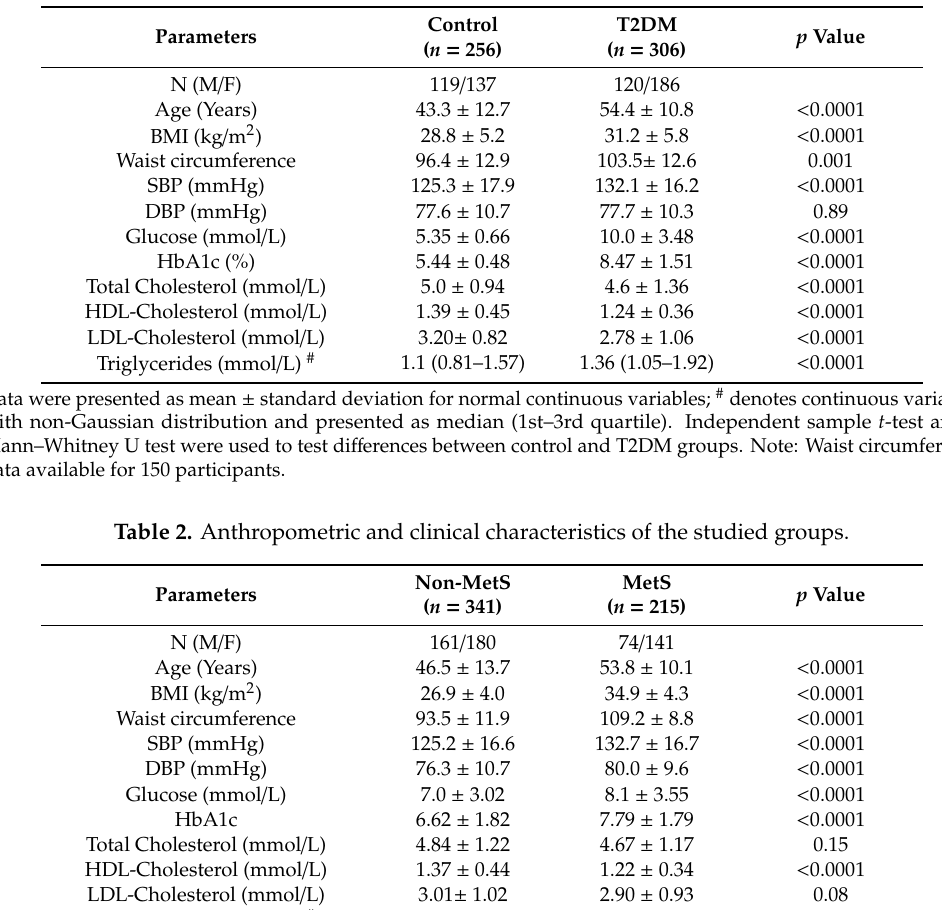
Table 1. Anthropometric and clinical characteristics of the studied groups.